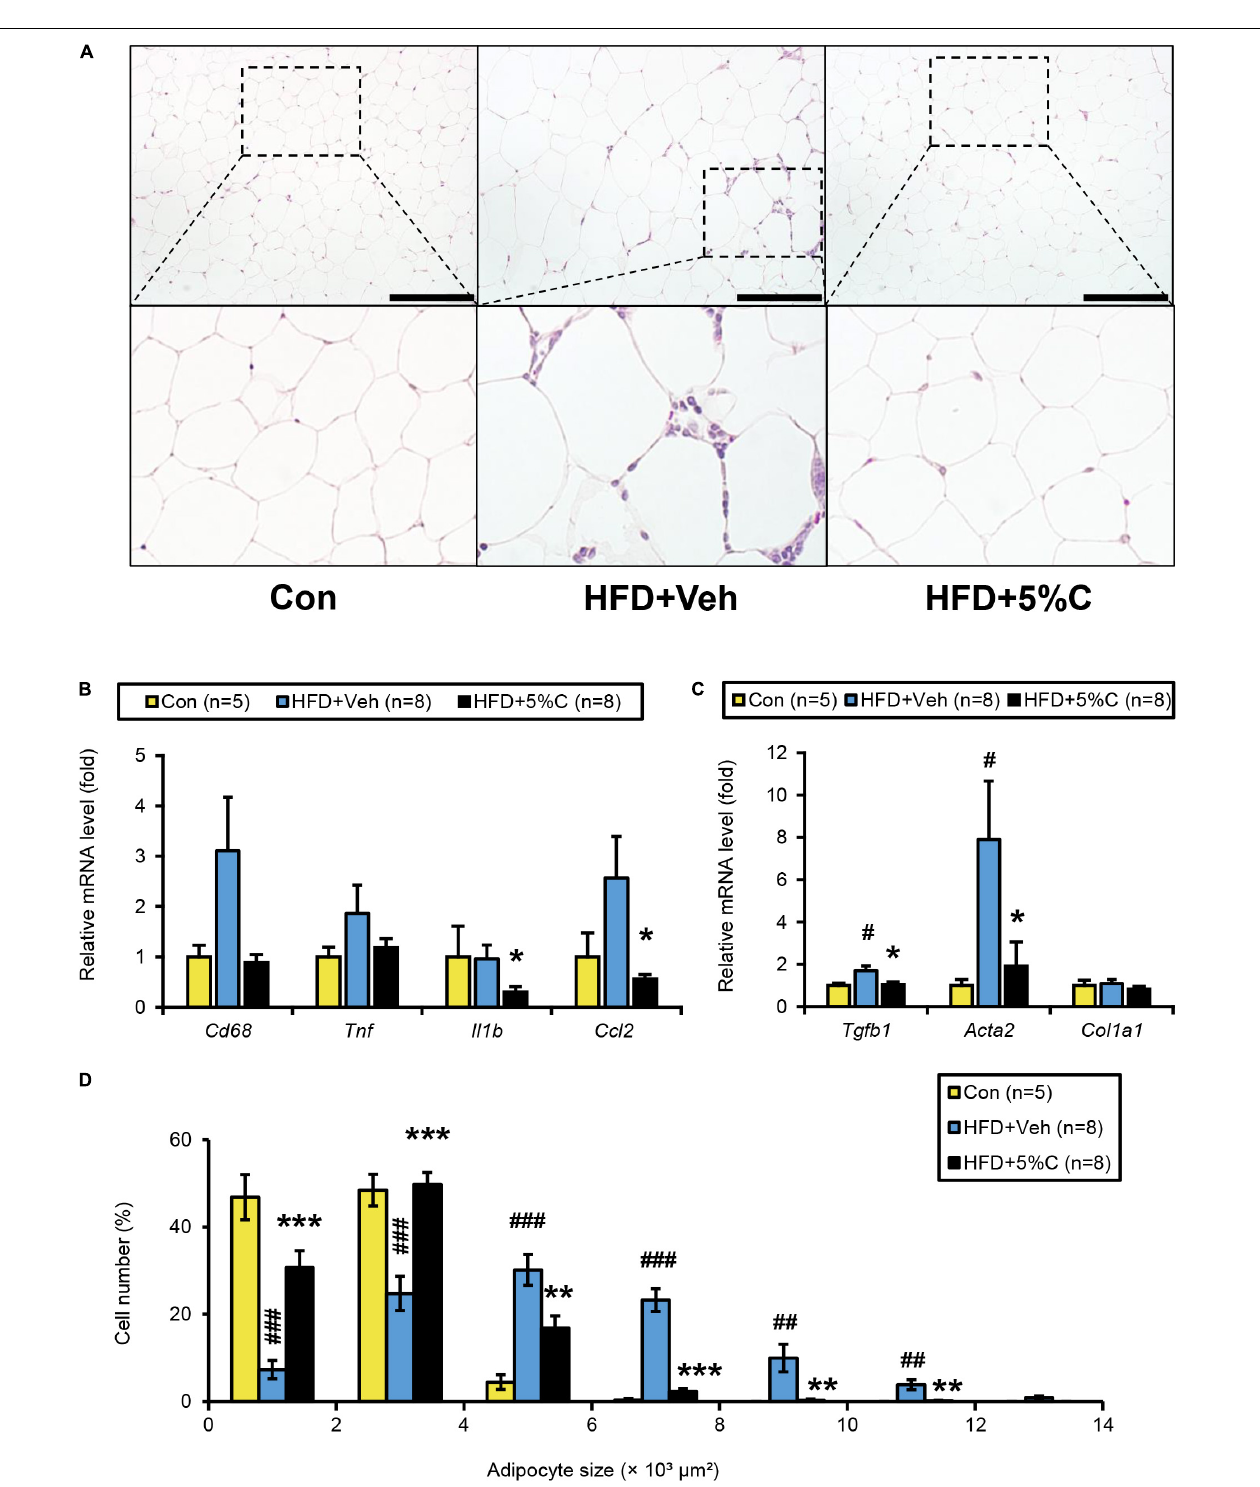
FIGURE 3 | Changes in eWAT after activated charcoal treatment. (A) Histological appearance of eWAT. The sections were stained with hematoxylin and eosin. Scale bars = 150 µ m (x200 magnification). (B) The mRNA levels of genes related to inflammation ( Cd68, Tnf, Il1b, and Ccl2 ) in the liver. (C) The mRNA levels of genes related to fibrosis ( Tgfb1, Acta2, and Col1a1 ) in the liver. (D) Proportions of adipocytes of different sizes. Data are expressed as the mean ± SEM. Statistical analysis was performed using two-tailed Student’s t -tests. * P < 0.05, ** P < 0.01, and *** P < 0.001 between the HFD + Veh group and the HFD + 5%C group. # P < 0.05, ## P < 0.01, and ### P < 0.001 between the HFD + Veh group and the Con group.